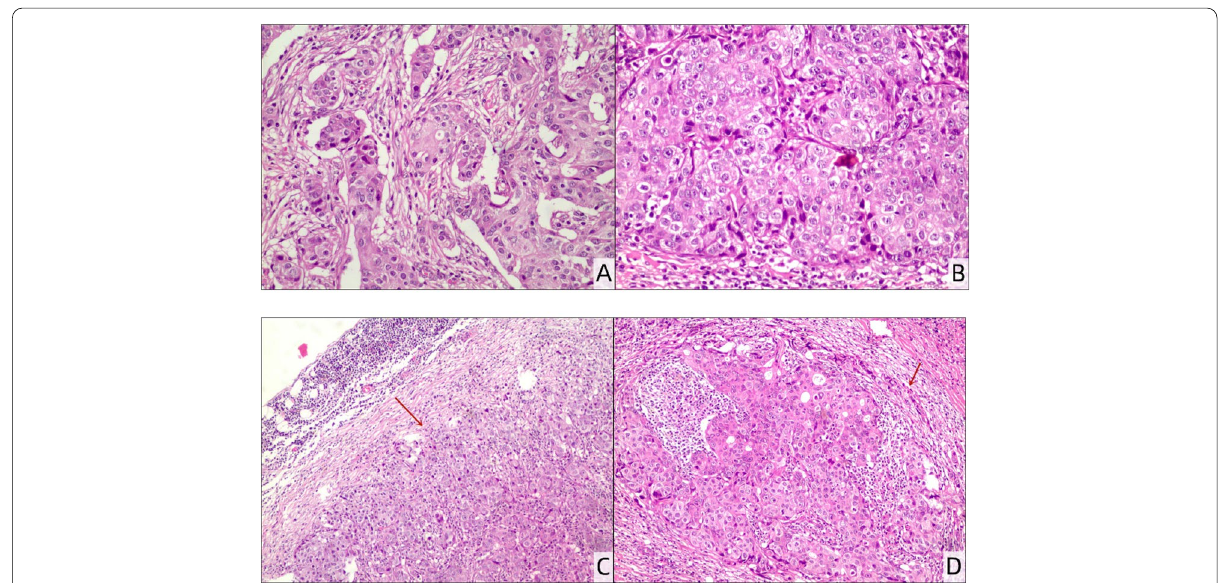
Fig. 2 Postoperative pathological section of the right breast ( A , B : H&E. 200 neck lymph node after surgery ( C : H&E. 40